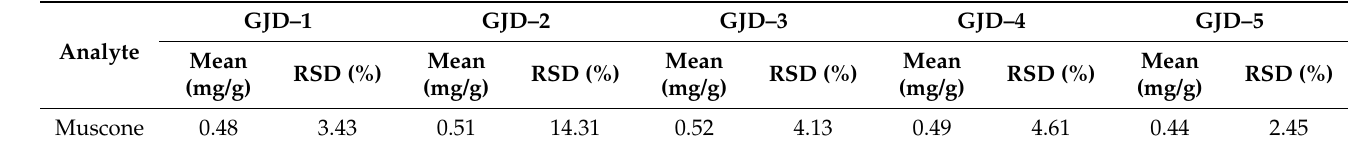
Table 10. Amounts (mg/g) of muscone in commercial products determined using the GC–MS/MS method 1